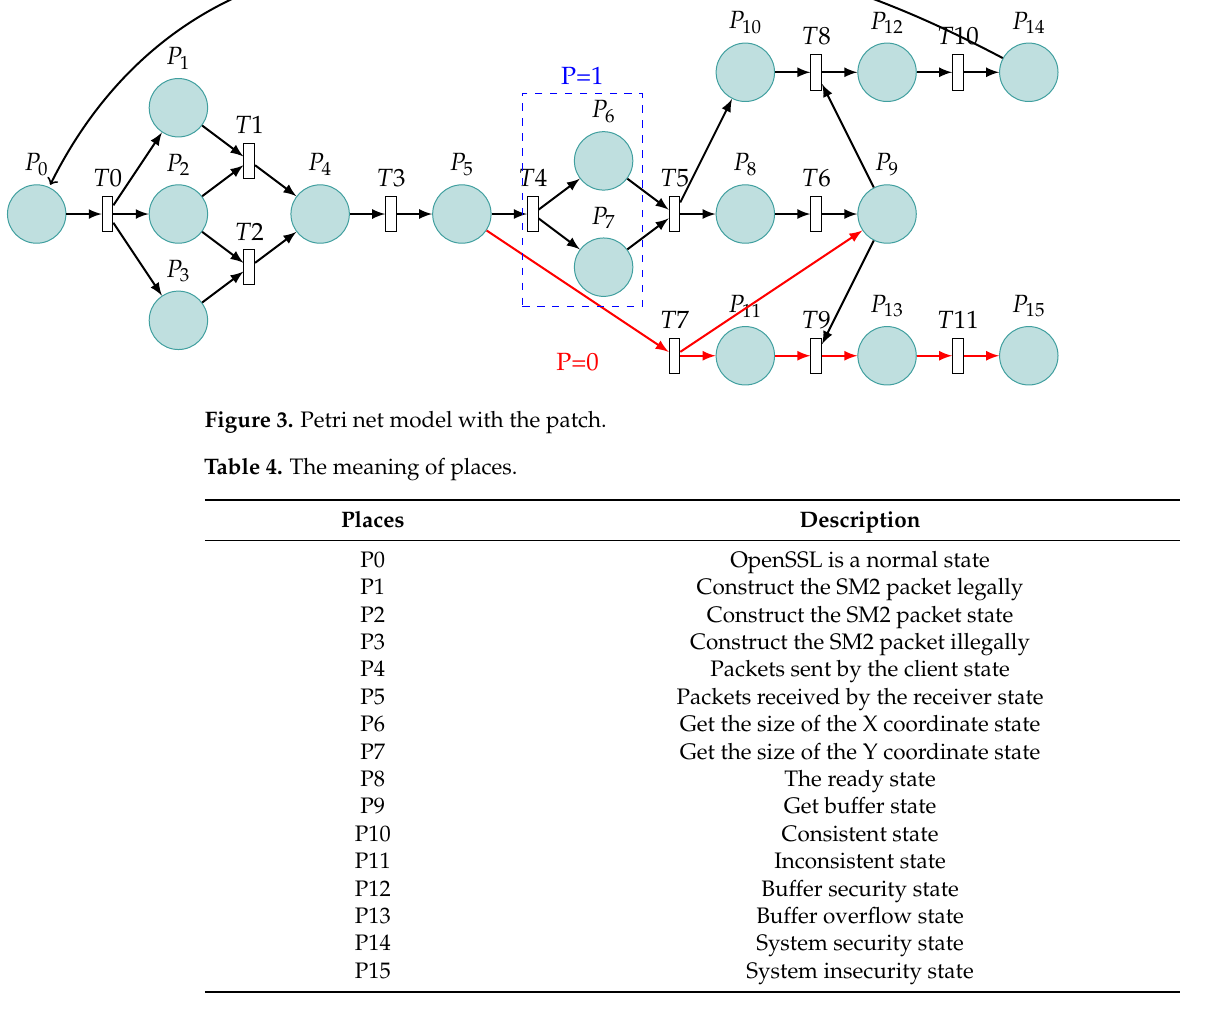
Table 5. The meaning of transitions.